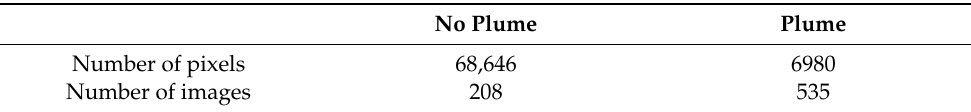
Figure 8. Classwise distribution of the two main features of the dataset: NO 2 and Moran’s I . Table 2. The number of measurement points per class in the